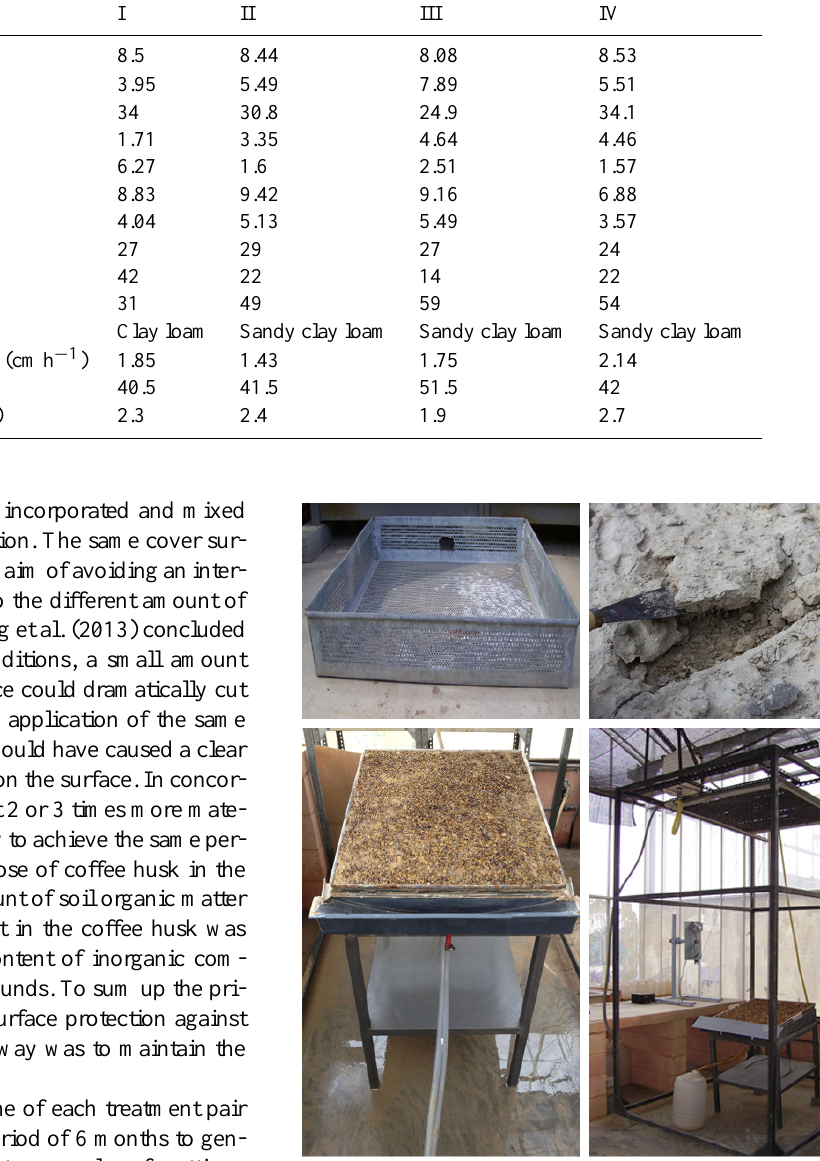
Table 1. Analytical characteristics of soils. Soil parameters